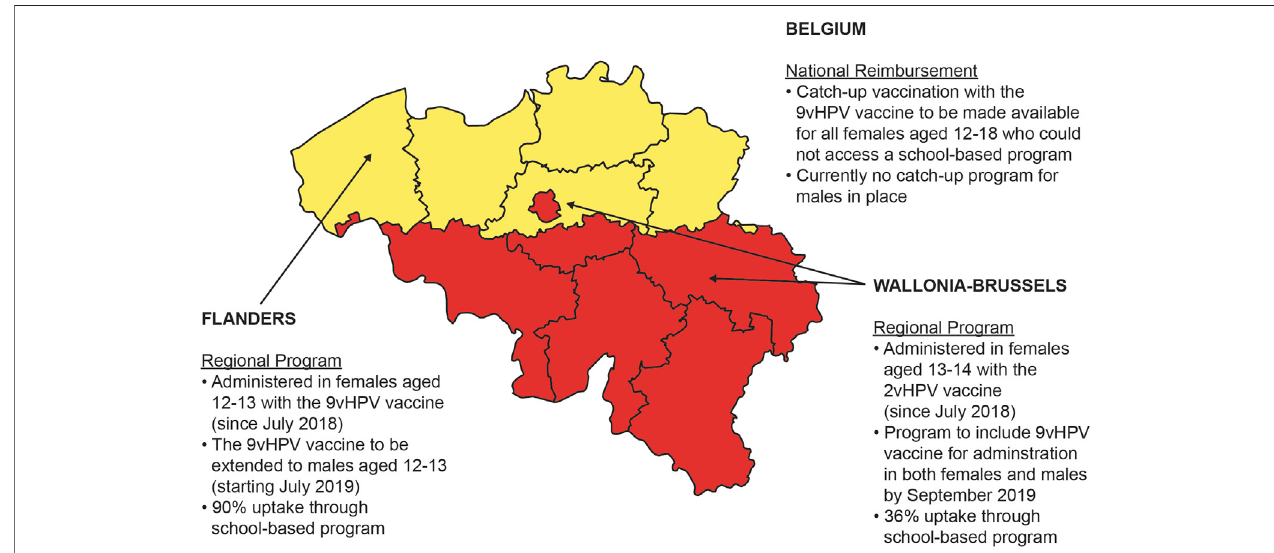
FIGURE 1 | National reimbursement and regional programs for HPV vaccination in Belgium.